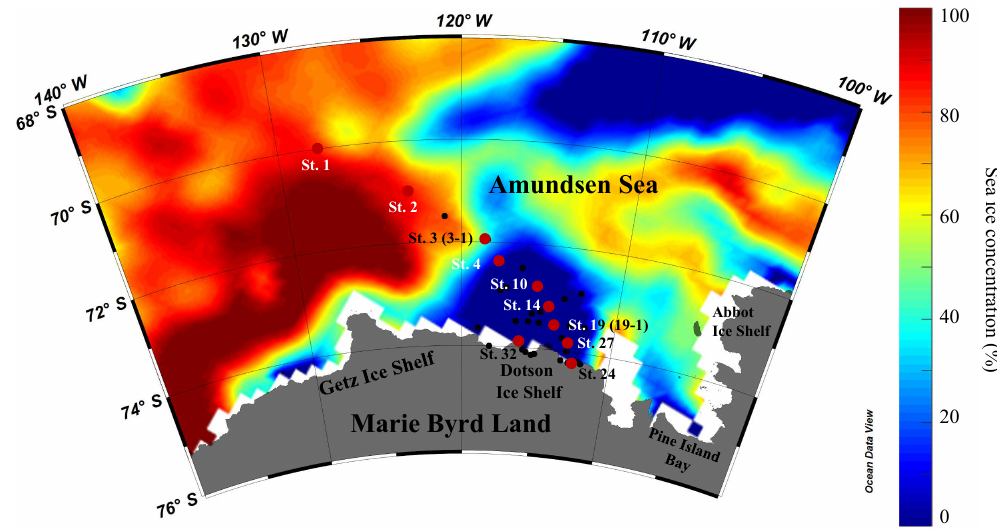
Figure 1. Sampling locations in the Amundsen Sea. Red closed circles represent productivity stations. Sea ice concentration data during the cruise period in 2013 from Nimbus-7 SMMR and DMSP SSM/I-SSMIS Passive Microwave data provided by National Snow and Ice Data